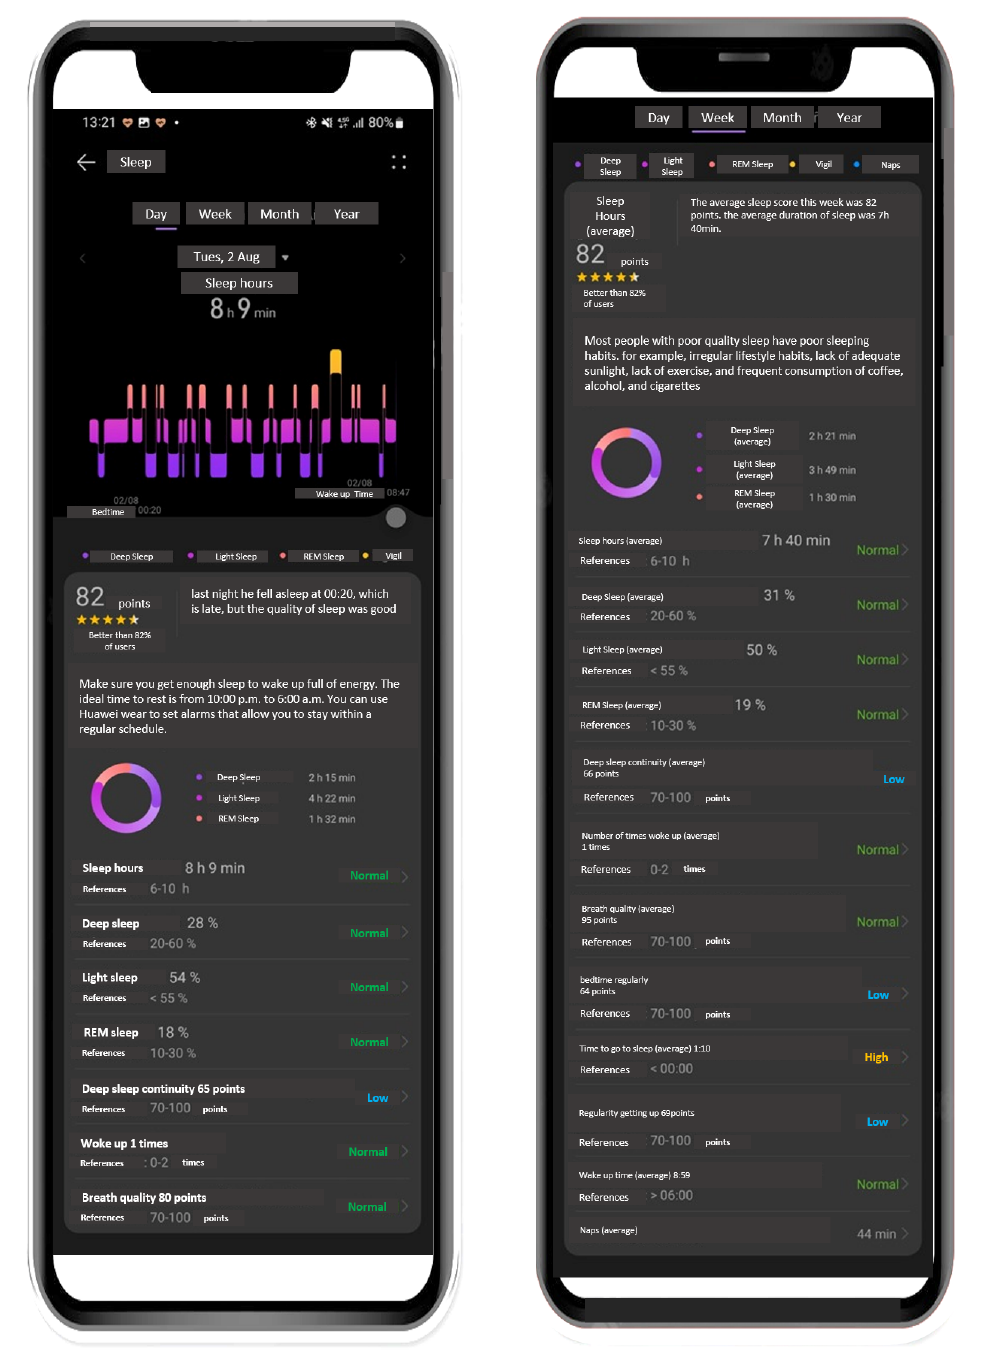
Figure 18. Example of a sleep improvement application with the sensor network for a user. Screen- shots of the cell phone corresponds with sensor